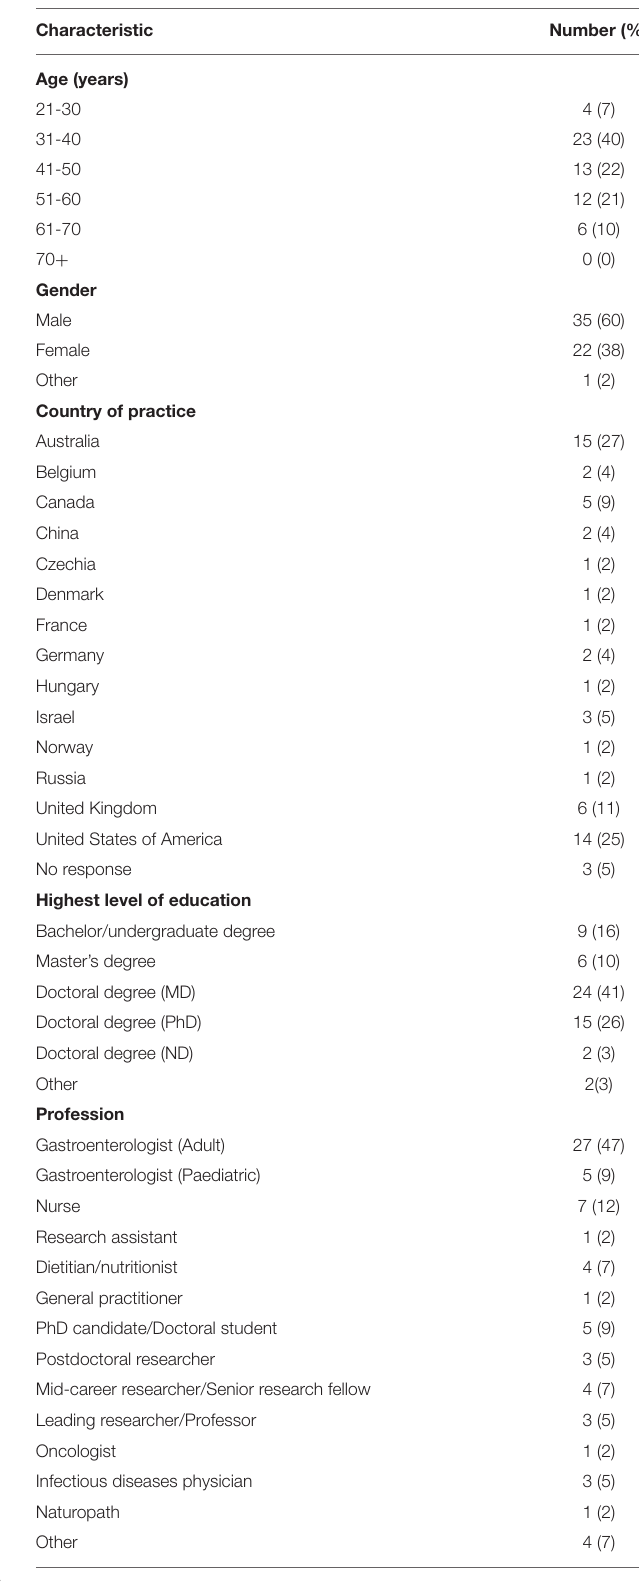
TABLE 1 | Survey questions. TABLE 2 | Demographics of the participants ( n =